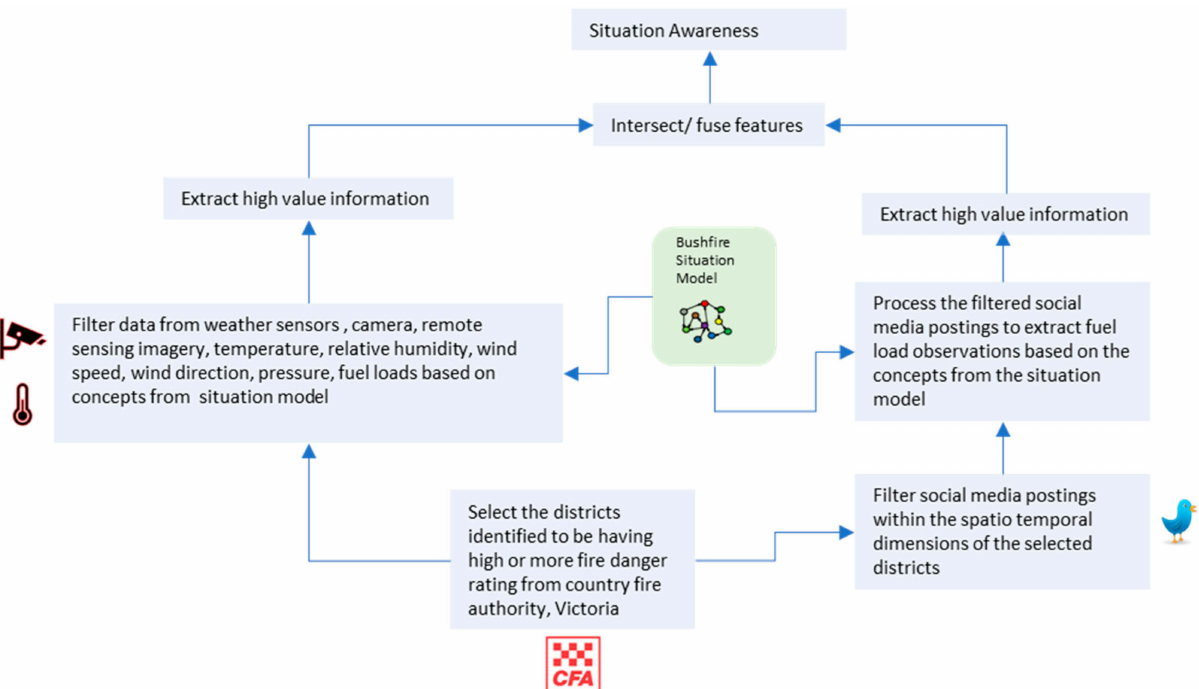
Figure 1. Illustration of the physical infrastructure and data analysis tasks for identifying potential fire hotspots and improving bushfire emergency management in a CPSA